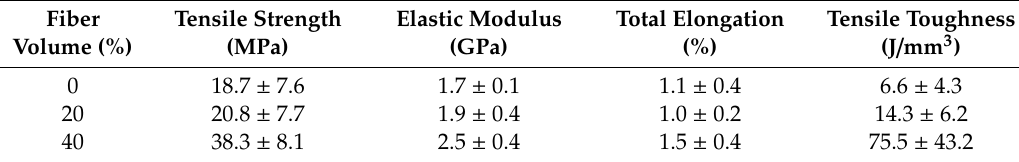
Table 2. Results for tensile test of the tucum fiber epoxy composites.